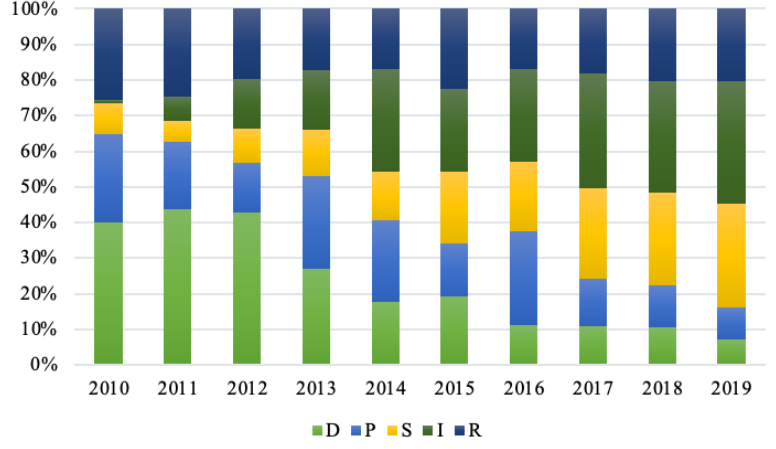
Figure 4. Contribution ratios of water resource carrying capacity subsystems of Zhengzhou from 2010 to 2019.